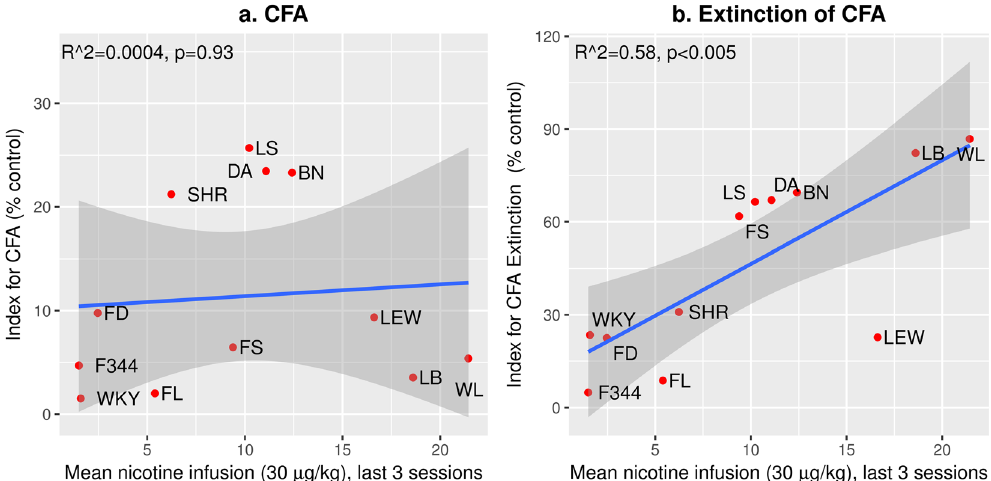
Figure 6. Correlation between nicotine intake and indices for CFA and extinction of CFA. The CFA index ( a ) was calculated using data obtained from the first extinction session (i.e. session four, Fig. 5). The extinction index ( b ) was calculated using data obtained from session eight. The correlation between the number of nicotine infusions at 30 μ g/kg/inf with both indices were calculated. The gray area represents the 95% confidence interval of the linear